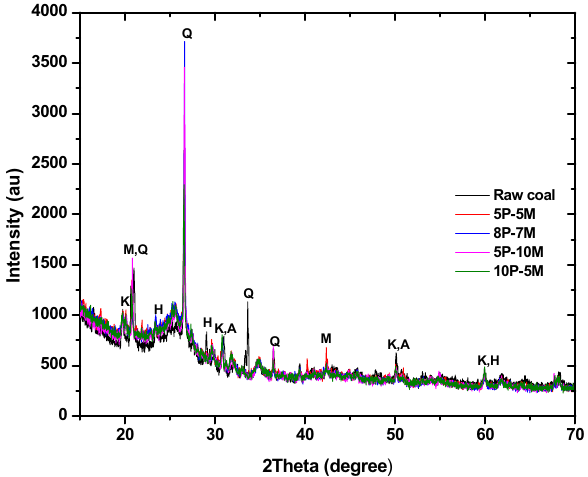
Figure 1. Diffractograms of bio-coal briquette produced from 97:3 hybrid